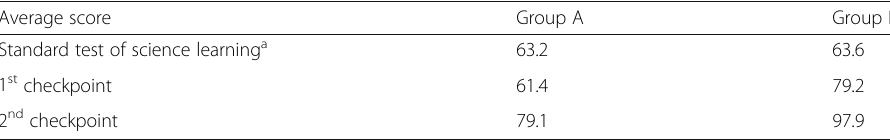
Table 3 Percentage of average